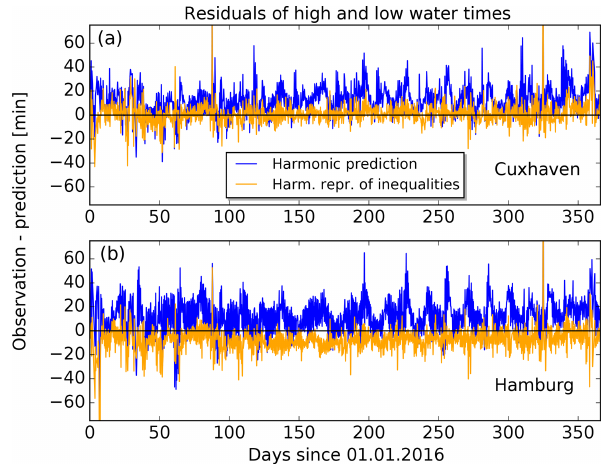
Figure 14. The residuals of high- and low-water times for the tide gauges Cuxhaven (a) and Hamburg (b)